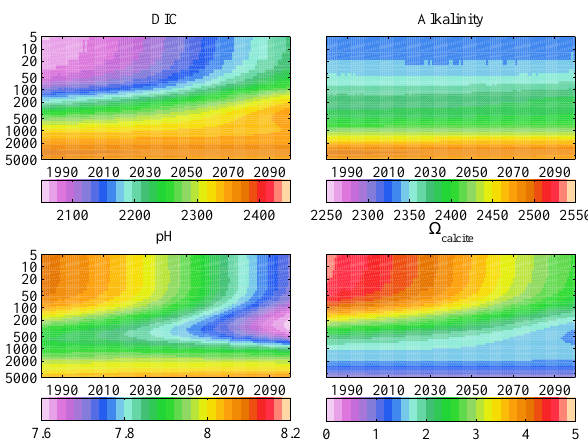
Fig. 18. Time evolution of global vertical profiles of DIC (top left; Fig.16. TimeevolutionofglobalverticalprofilesofDIC( topleft ;mmolCm − 3 ),alkalinity( topright ;meqm − 3 ),pH ( bottomleft ;–)and Ω calcite ( bottomright ;–). mmolCm − 3 ), alkalinity (top right; meqm − 3 ), pH (bottom left; –) and (cid:127) calcite (bottom right;